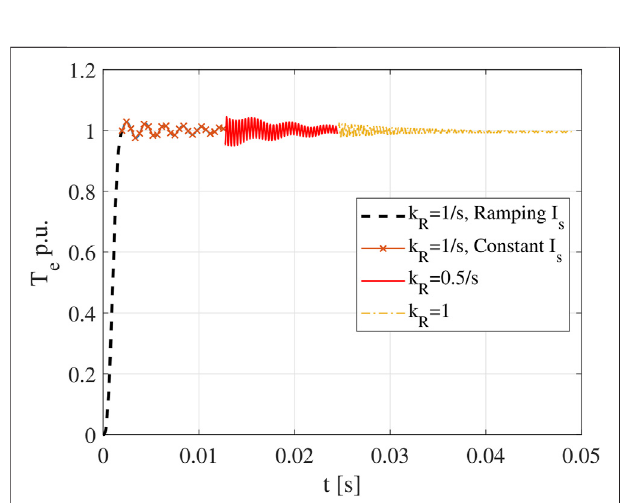
FIGURE 3 | τω slip vs. k ω * at various k R values with the ramp function e 3 ( k